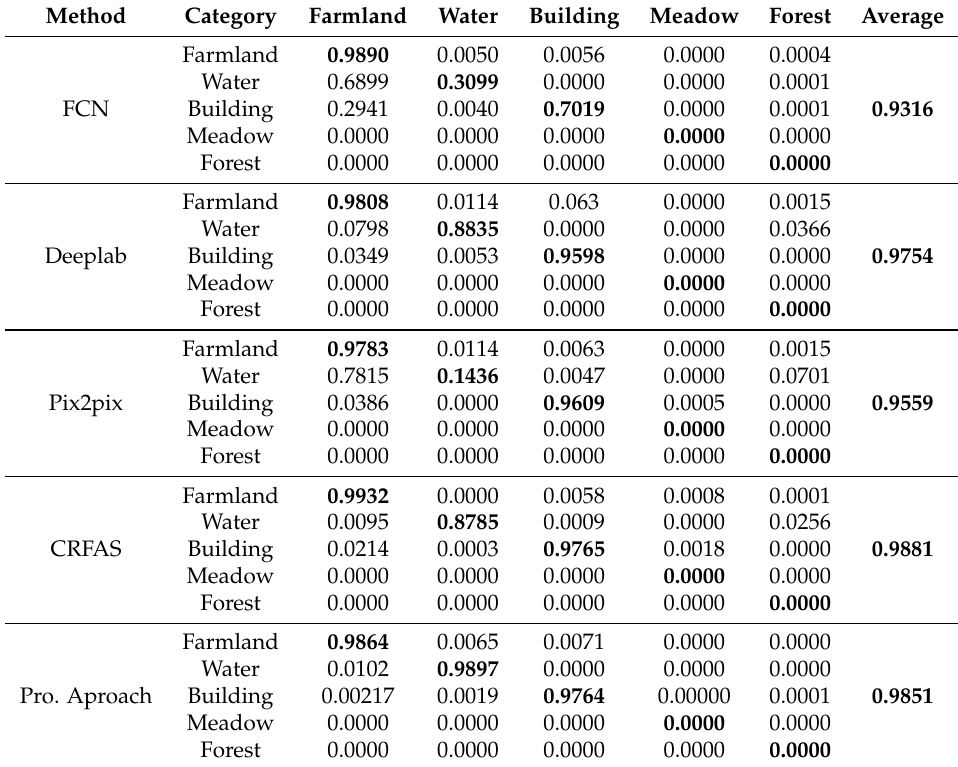
Table 4. Confusion matrix for GID-image3.